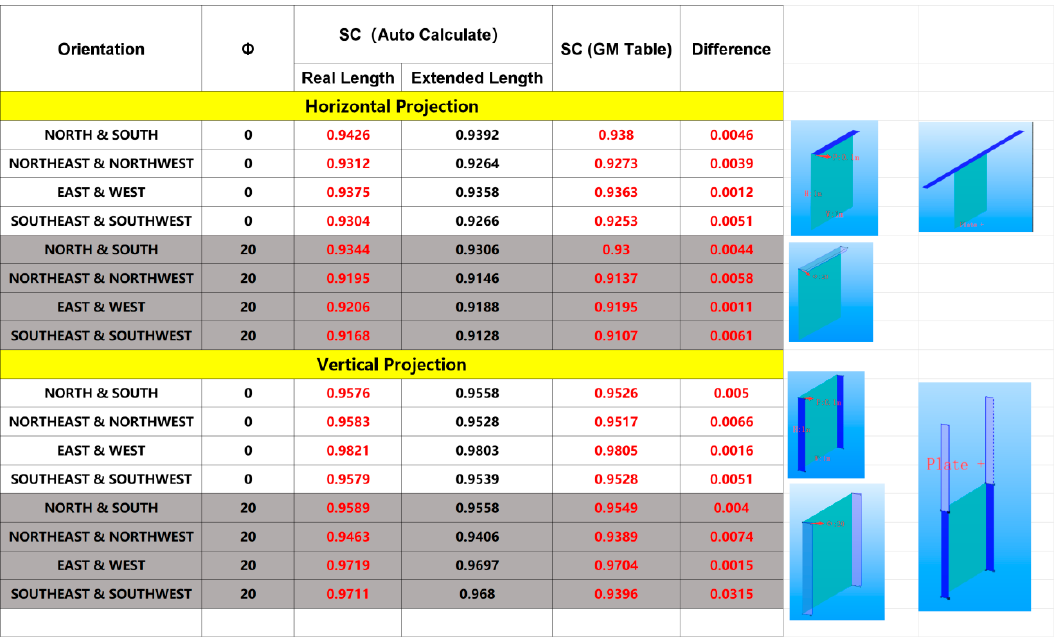
Figure 17. SC2 calculation by using the proposed method.